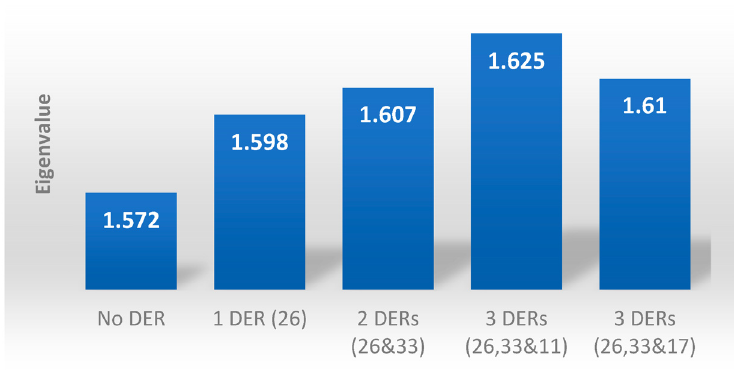
Figure 14. System eigenvalues with the CPF approach and the proposed method.